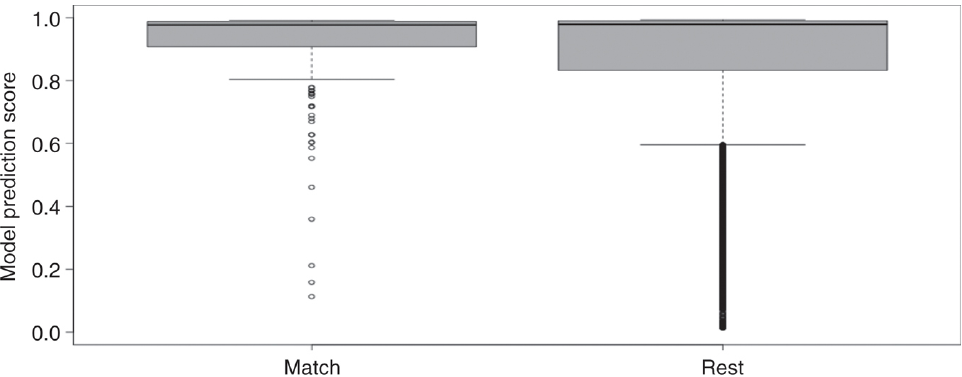
Figure 4: Model score distribution for clusters 0 – 2 from Figure 3. Cluster 0: Minimum 0.012, Lower whisker 0.412, Lower quartile 0.758, Median 0.915, Upper quartile 0.988, Upper Whisker 0.992, Maximum 0.992; Cluster 1: Minimum 0.015, Lower whisker 0.110, Lower quartile 0.628, Median 0.837, Upper quartile 0.973, Upper Whisker 0.993, Maximum 0.993; Cluster 2: Minimum 0.098, Lower whisker 0.965, Lower quartile 0.980, Median 0.989, Upper quartile 0.991, Upper Whisker 0.992, Maximum 0.992.